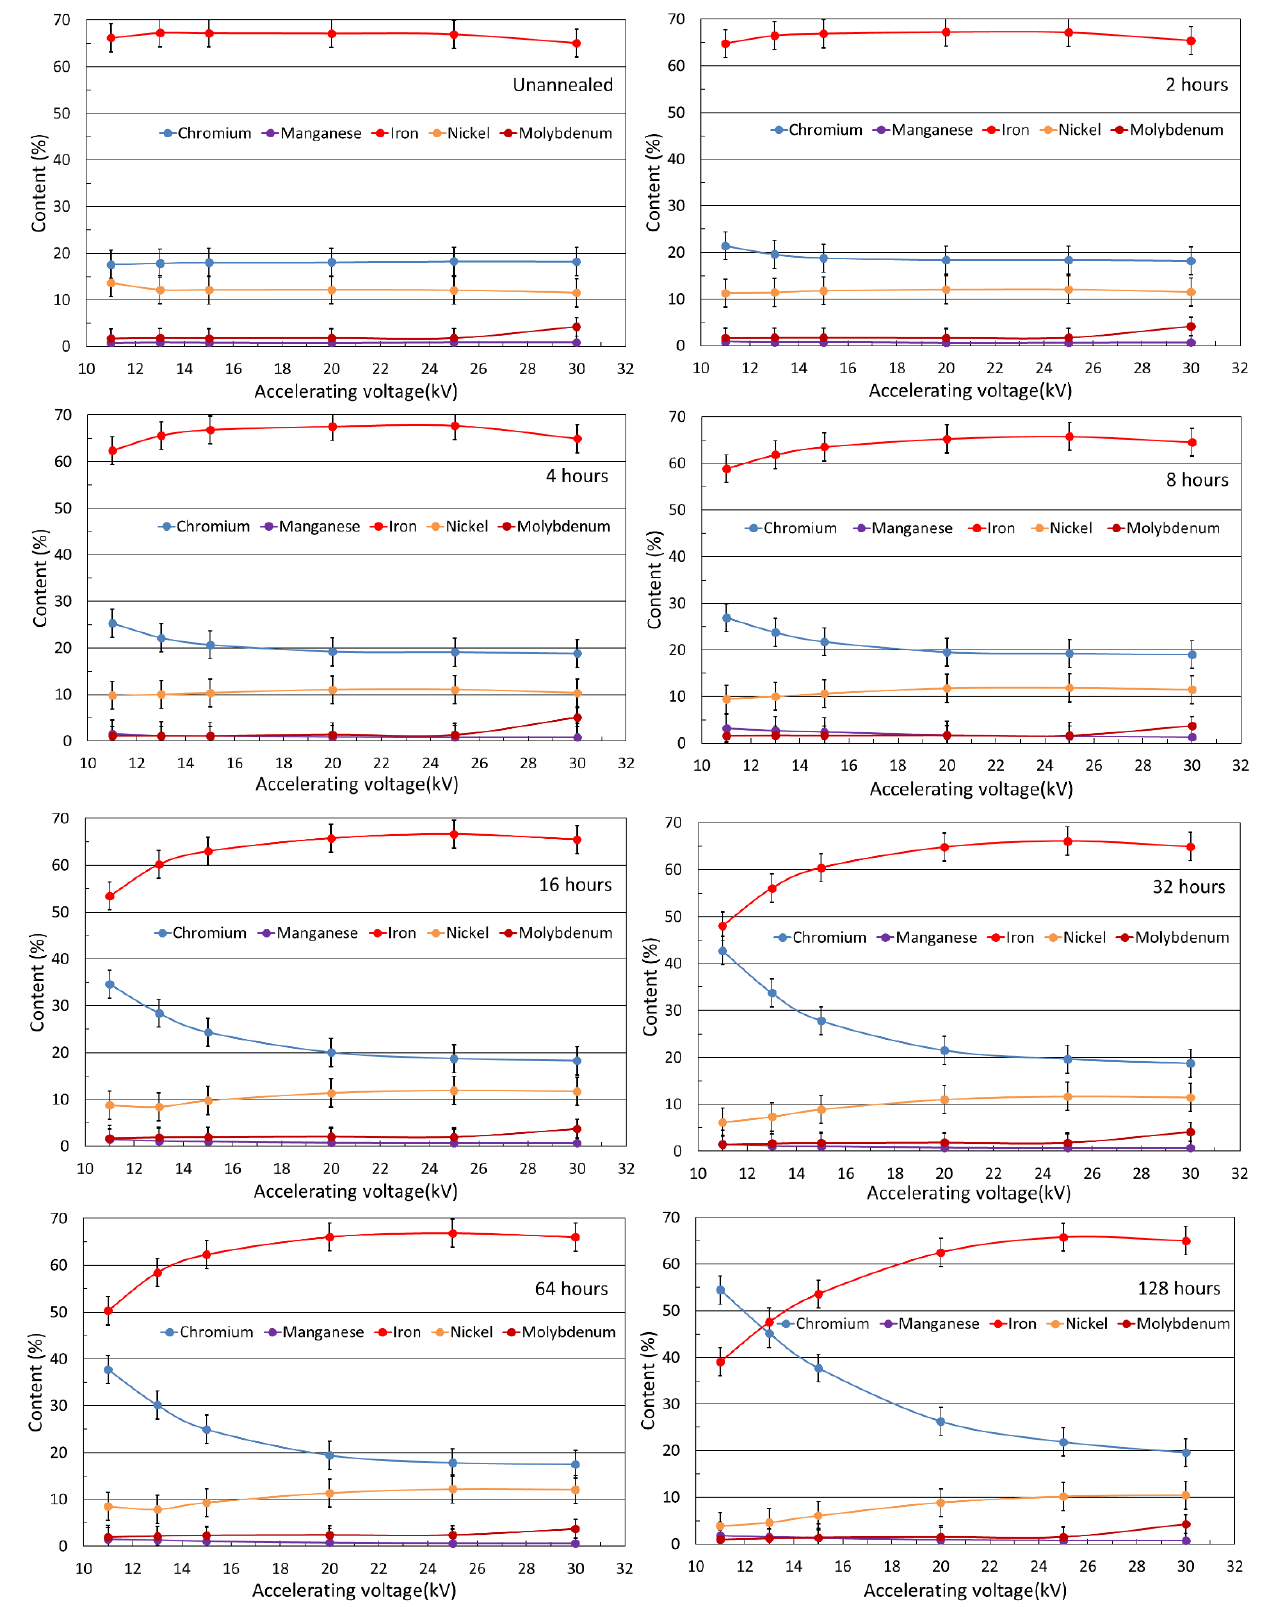
Figure 2. In-depth elemental analysis of selected samples by energy-dispersive X-ray spectroscopy.